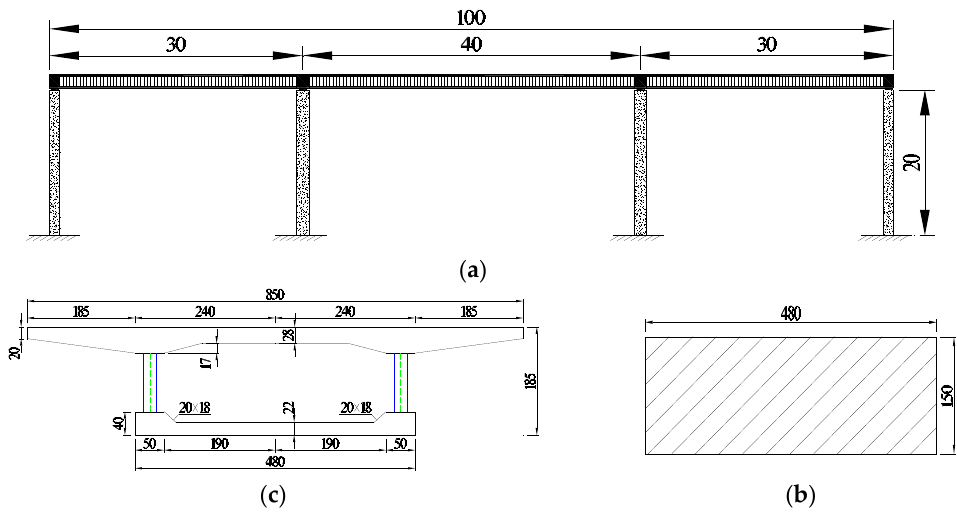
Figure 1. Overall arrangement of the composite bridge: ( a ) bridge elevation drawing (unit: m); ( b ) box girder section (unit: cm); ( c ) pier section (unit: cm).